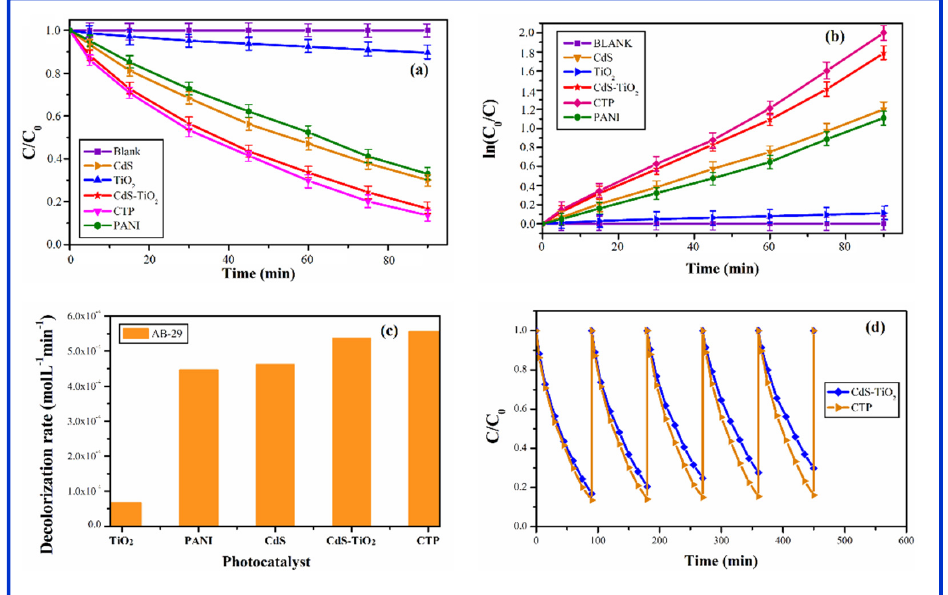
Figure 12. ( a ) Change in concentration of AB-29 with time in the presence and absence of CTP in comparison to PANI, CdS and TiO 2 nanoparticles and CdS-TiO 2 nanocomposite ( b ) Change in concentration of AB-29 with time in the presence and absence of CTP in comparison to PANI, CdS and TiO 2 nanoparticles and CdS-TiO 2 nanocomposite ( c ) The decolorization rate of AB-29 in the presence of synthesized CTP in comparison to PANI, CdS and TiO 2 nanoparticles and CdS-TiO 2 nanocomposite ( d ) Stability and recycle of CdS-TiO 2 nanocomposite embedded in PANI (CTP) in comparison to free CdS-TiO 2 nanocomposite without PANI.